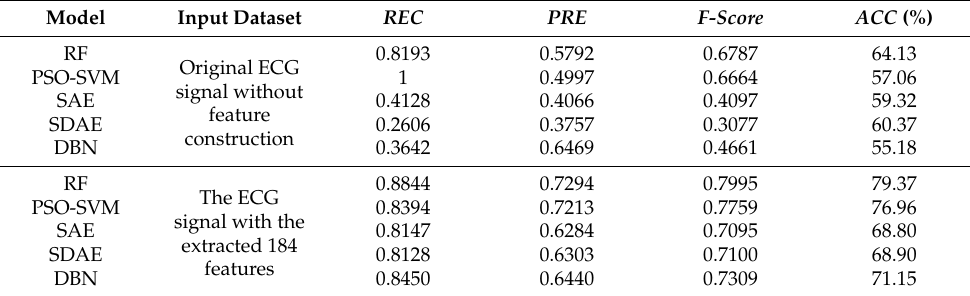
Table 5. The performance comparison of different models.